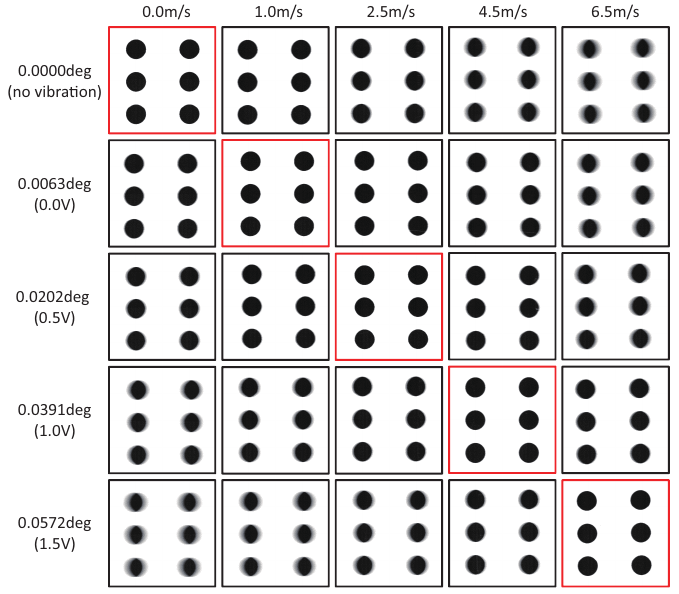
Figure 14. Images of a circle-dot pattern when video shooting without amplitude control. For a circle-dot pattern, the blur index λ dot = λ x − λ 0 was introduced; λ x represents the length x of the x -axis of the approximated ellipse of the circle dot in the image, and λ 0 is the value of λ x in x observing a circle-dot at a fixed location in the case of no vibration of the resonant mirror. The index λ dot increases as the motion blur in the horizontal direction becomes larger in the image, and it becomes zero when the circle-dot has no motion. λ x was estimated offline by computing its zero-, first- and second-order moment features for the circle-dot region in the 424 × 424 image cropped from the input image; a single circle-dot was located at the center of the cropped image. The circle-dot region was extracted by binarization with a threshold of